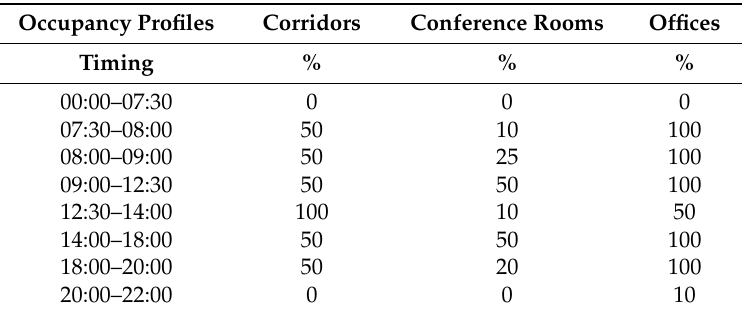
Table 2. Occupancy profiles for main spaces.